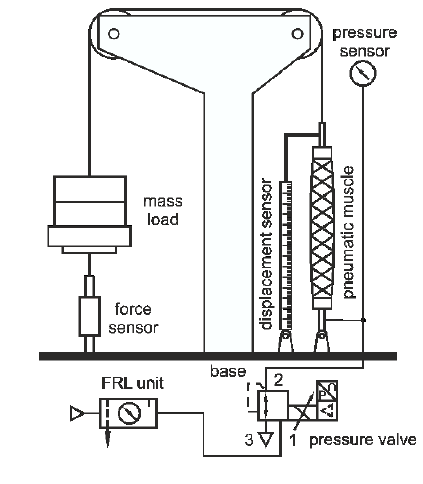
Fig. 3. Diagram of the test stand.